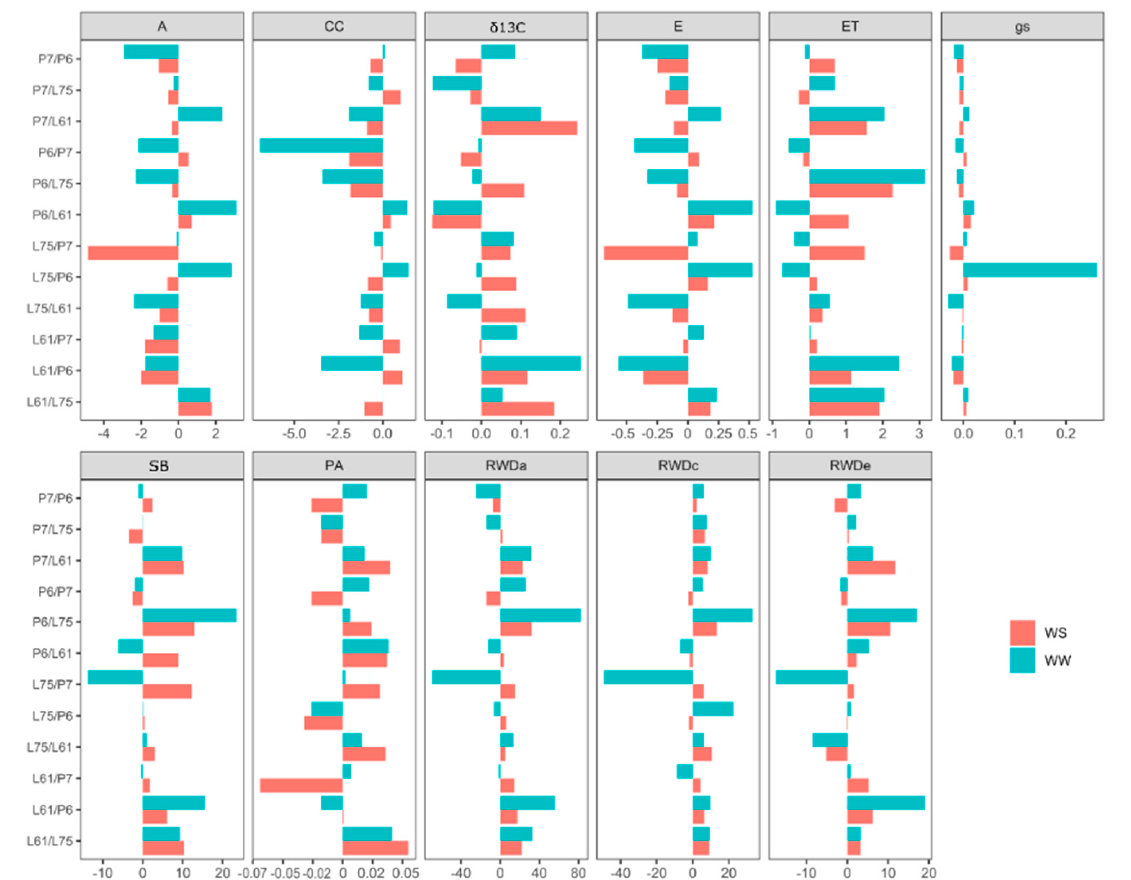
Figure 4. Estimates of specific combining ability (SCA) effects for morphological traits, water status, and root traits in popcorn hybrids under water stress (WS) and well-watered (WW) conditions. WS: water stress; WW: well-watered; SB: shoot biomass; PA: whole plant area; CC: chlorophyll concentration (Dualex index); δ 13 C: carbon isotope discrimination; A: net CO 2 assimilation rate; gs : stomatal conductance; E: transpiration; ET: cumulative plant transpiration; RWD a : root weight density of the section a (0–30 cm); RWD c : root weight density of the section c (60–90 cm); RWD e : root weight density of the section e (120–150 cm).